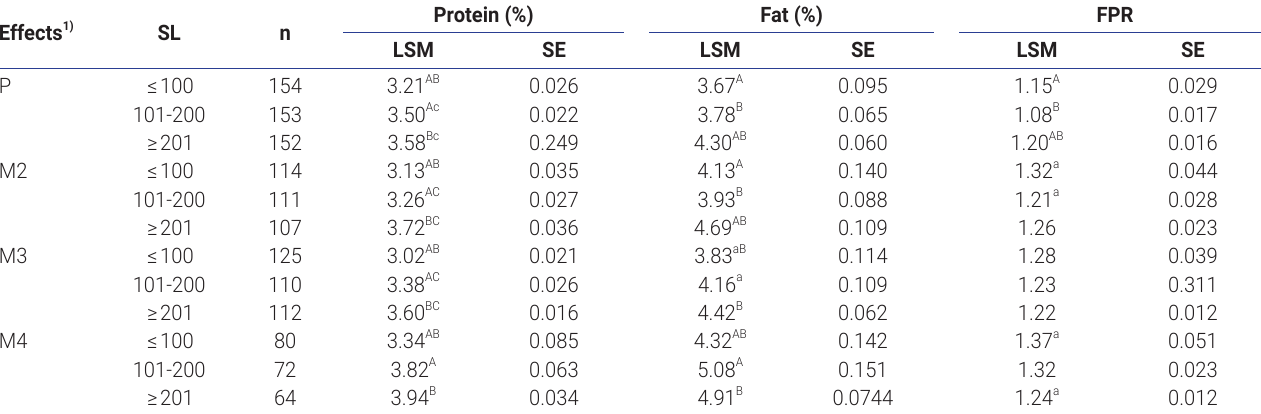
SL, stage of lactation, days postpartum; FPR, fat/protein ratio; LSM, least square mean; SE, standard error. 1) P, primiparous cows; M2, multiparous cows in 2nd lactation; M3, multiparous cows in 3rd lactation; M4, multiparous cows in 4th and subsequent lacta - tions. a-c values within a column with the same superscripts differ significantly at p≤0.05. A-C values within a column with the same superscripts differ significantly at p≤0.01.